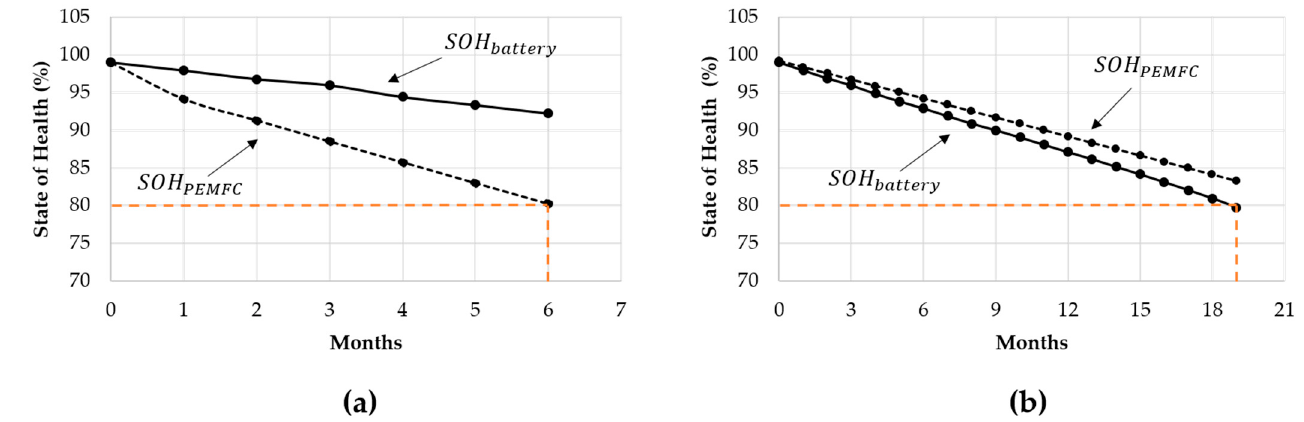
Figure 3. SOH of LFP battery and PEMFC during the plant lifetime for ( a ) fuel consumption minimization only optimization and ( b ) newly proposed long-term operation optimization approach. The dashed orange lines indicate the threshold values of SOH. The solid black lines represent the SOH of LFP battery, the dashed black lines the SOH of PEMFC.